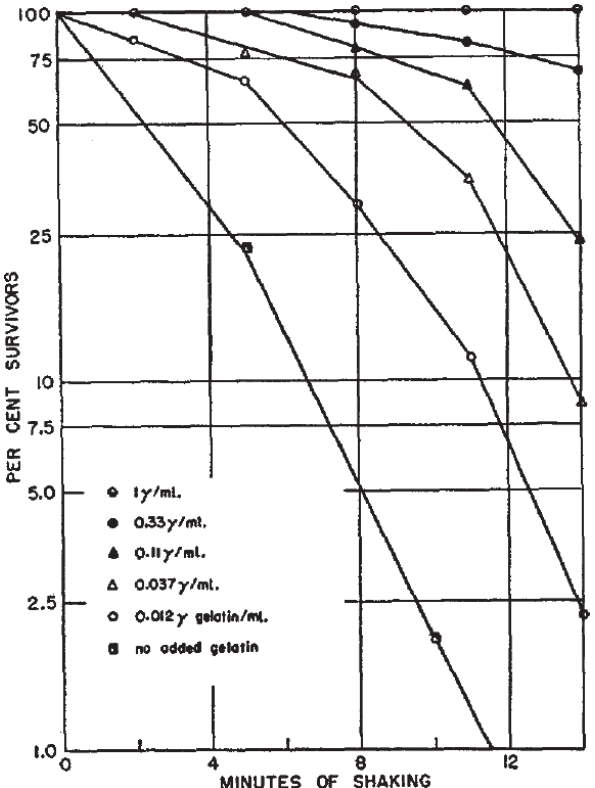
Figure 2. The inactivation of phage T 6 , shaken in the presence of various amounts of